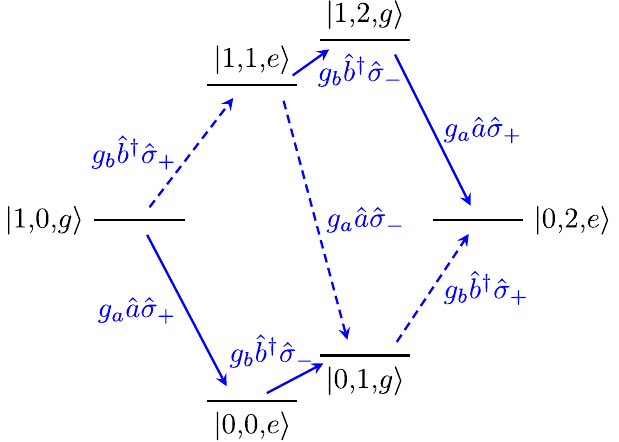
Figure 5. The lowest-order processes contributing to a transition between |1, 0, g 〉 and |0, 2, e 〉 in the quantum Rabi model. The transitions that do not conserve excitation number are shown as dashed blue lines and the excitation-number-conserving transitions are shown as solid blue lines. The label of each line is the term in Eq. (6) that gives rise to that transition. The parameters ω a = 5 ω q and ω b = 2 ω q were used to set the positions of the energy